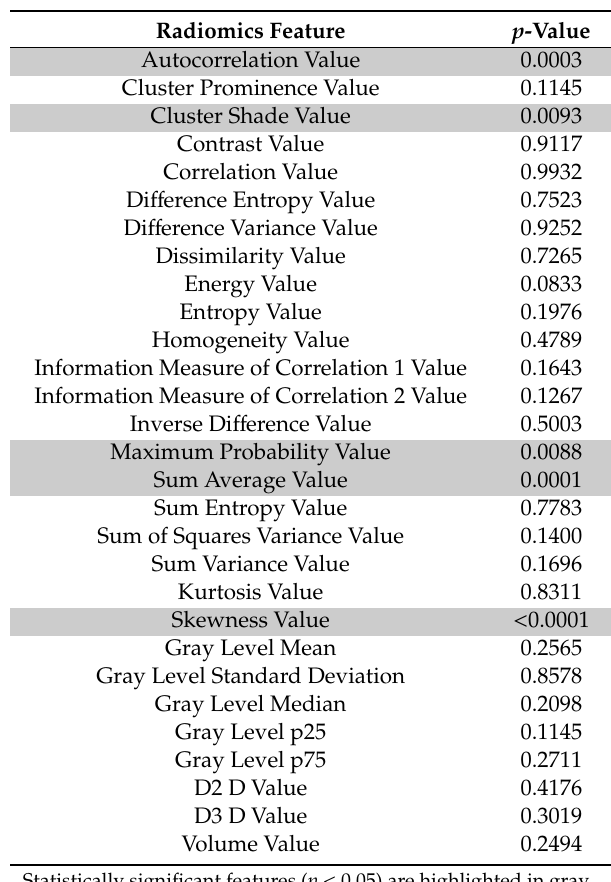
Table 2. Values of MR radiomics features of pleomorphic adenoma versus Warthin